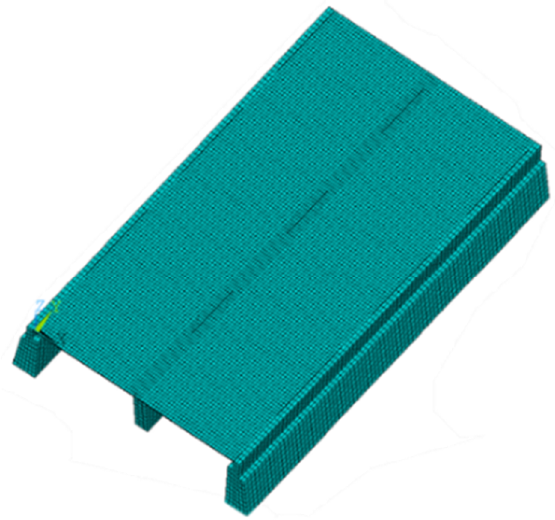
Figure 3. FEM of the taxiway